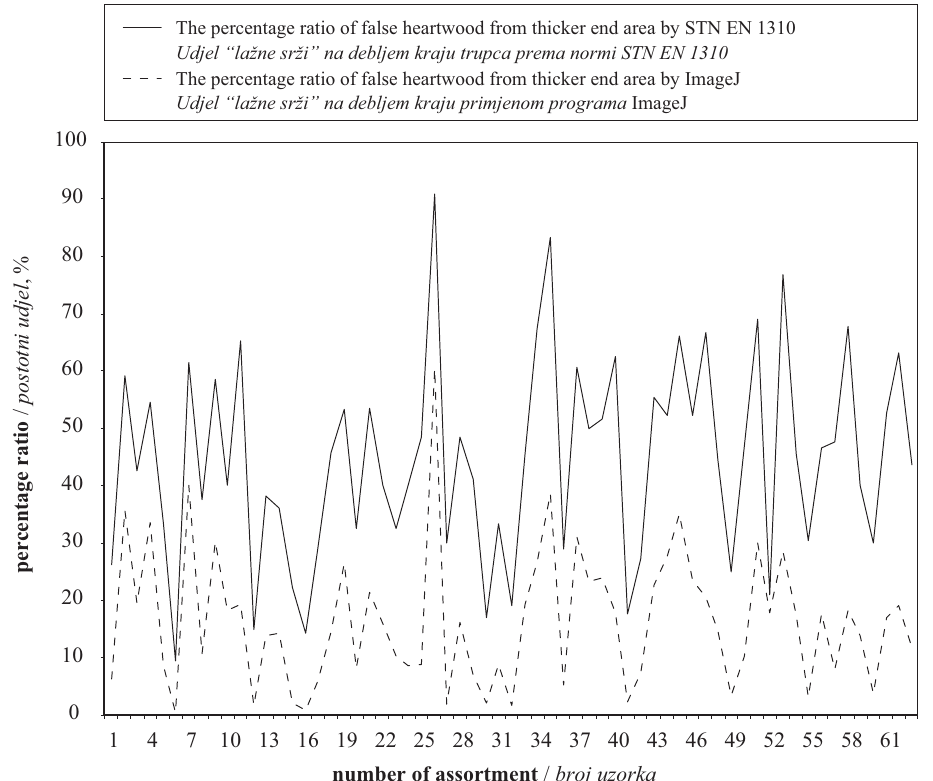
Figure 5 Percentages of false heartwood on total log area according to STN and program ImageJ Slika 5 . Postotak površine “lažne srži” na ukupnoj površini trupca prema normi STN dobiven primjenom programa